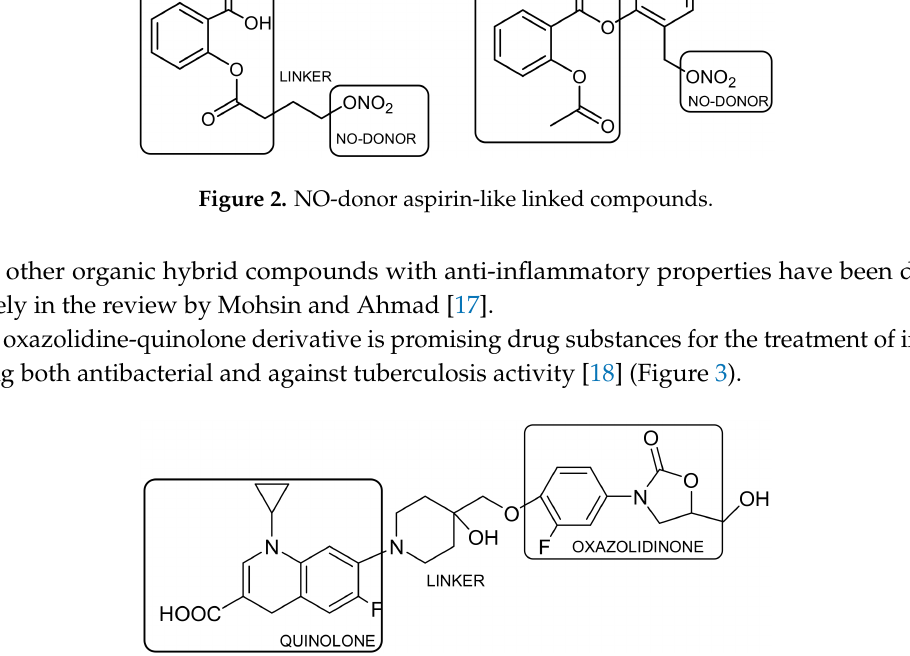
Figure 3. Oxazolidine-quinolone hybrid (Cadazolid).